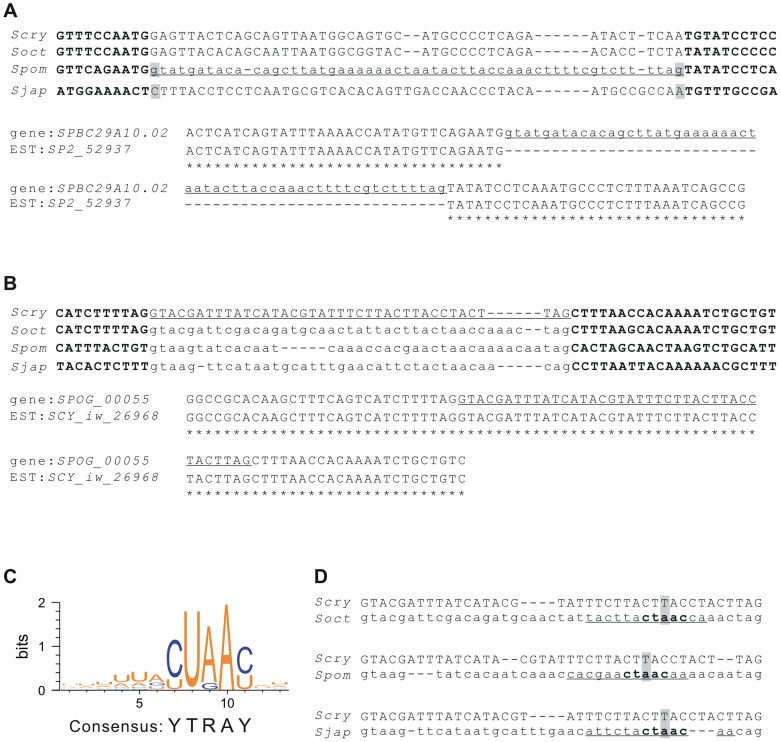
Intronization and de-intronization events in fission yeasts.A) Intronization occurred in the SPBC29A10.02 gene of S. pombe. The intronized region is marked by underlining and variations in splice sites are marked in gray. Alignment of gene SPBC29A10.02 with its related EST is shown below. B) De-intronization occurred in the SPOG_00055 gene of S. cryophilus. Alignment of SPOG_00055 with its orthologs shows a de-intronization event, with the exonized region marked by underlining. Alignment of gene SPOG_00055 with its related EST is shown below. C) The consensus sequence (YTRAY) of branch sites in fission yeasts. Branch site sequences were detected using ICAT [53] and consensus sequences were generated using Weblogo [54]. D) The degraded branch sites of SPOG_00055 compared with its orthologous intron regions. The branch sites predicted by ICAT are marked by underlining and the consensus regions in the branch sites are in bold. Mutations are marked in gray. The introns are shown in lower case while exonic sequences are presented in upper case. Species name abbreviations: S. cryophilus (Scry), S. octosporus (Soct), S. pombe (Spom), and S. japonicus (Sjap).